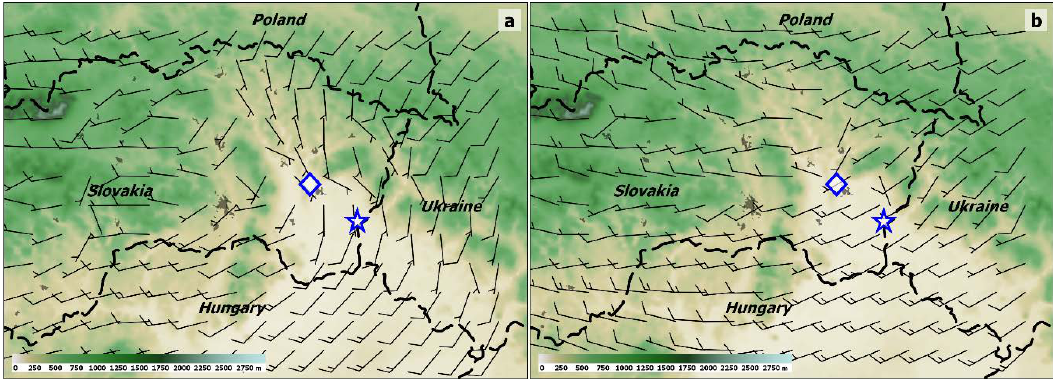
Figure 5. NWP OPM forecast of surface winds on 3 October 2018 06:00 UTC (m · s − 1 ) over eastern Slovakia at ( a ) 08:00 and ( b ) 12:00 UTC. Real topography shown as background; polygons: locations of larger towns in Slovakia. Country names shown in italics; tornado location highlighted by blue star; tephigram location from Figure 4 highlighted by blue